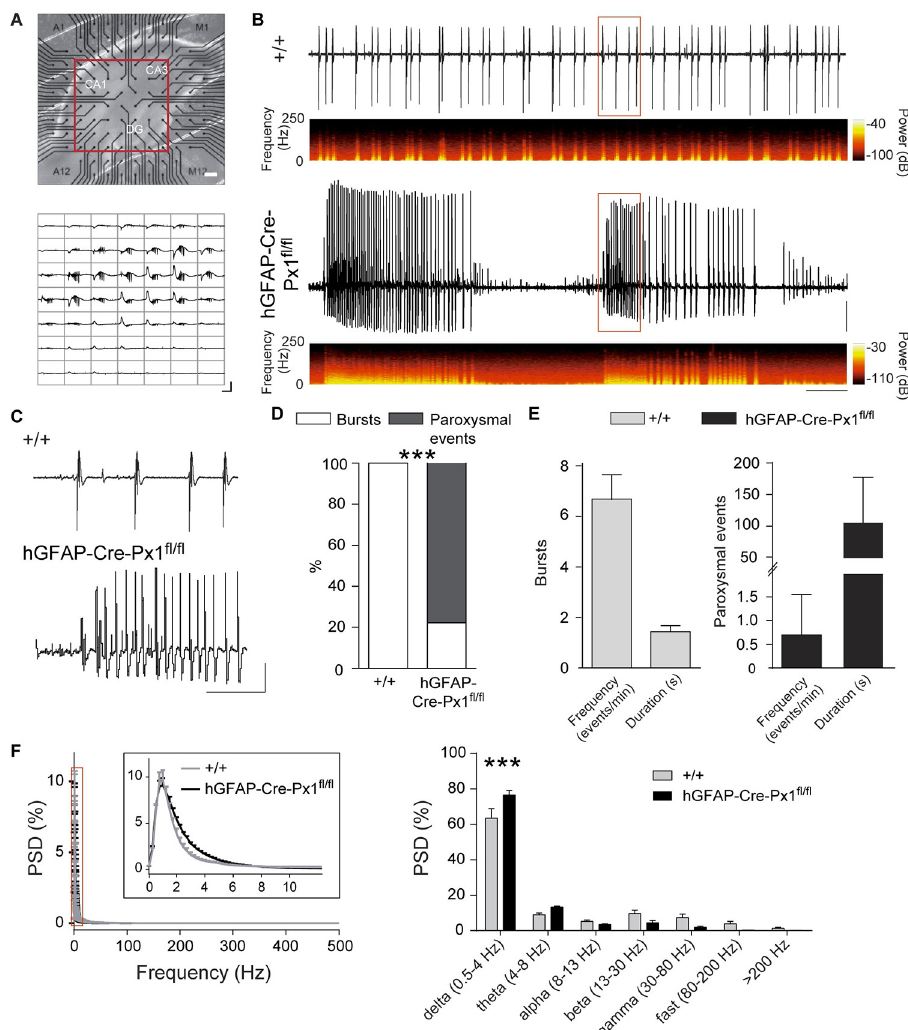
Fig 2. Astroglial Px1 deficiency induces paroxysmal activity. ( A ) Top panel, hippocampal slice on a MEA chamber (DG: dentate gyrus). Bottom panel, illustration of bursting activity recorded using a MEA device (200 μ m interelectrode distance) in hippocampal slices. Scale bar: 500 ms, 0.3 mV. ( B ) Representative traces of bursting activity in +/+ mice (upper trace) and paroxysmal activity in hGFAP-Cre-Px1 fl/fl mice (lower trace). The corresponding time- frequency plots are shown under the traces. Scale bar: 30 sec, 0.2 mV. ( C ) Magnification of bursting activity in +/+ mice and paroxysmal activity in hGFAP-Cre-Px1 fl/fl mice highlighted by the red rectangles in panel B. Scale bar: 10 s, 0.2 mV. ( D ) Proportion of bursts and paroxysmal events recorded in +/+ and hGFAP-Cre-Px1 fl/fl mice (+/+, n = 13 slices from 6 mice; hGFAP-Cre-Px1 fl/fl , n = 18 slices from 8 mice; Fisher exact test). ( E ) Quantification of bursts and paroxysmal events frequency and duration (+/+, n = 13 slices; hGFAP-Cre-Px1 fl/fl , n = 14 slices). ( F ) Left, power spectral density of activity (normalised to the percent of the total PSD) recorded in +/+ (grey) and hGFAP-Cre-Px1 fl/fl (black) slices. The area highlighted by the red rectangle is zoomed in the inset. Right, power spectral density of left panel binned according to different brain rhythms: delta (0.5–4 Hz), theta (4–8 Hz), alpha (8–3 Hz), beta (13–30 Hz), gamma (30–80 Hz), fast (80–200 Hz), and > 200 Hz oscillations (+/+, n = 13 slices; hGFAP-Cre-Px1 fl/fl , n = 12 slices; p = 0.002, repeated measures two-way ANOVA). Asterisks indicate statistical significance ( � p < 0.05; ��� p < 0.0001). The data underlying this figure can be found in the S1 Metadata B tab. hGFAP-CreERT2 treated with TF) mostly displayed bursting activity (86%, n = 12 out of 14 slices from 3 mice for +/+ + TF; 77%, n = 20 out of 26 slices from 4 mice for hGFAP- CreERT2 + TF; p = 0.0106 and 0.027, respectively; S4C–S4G Fig). These results thus indicate that postnatal deletion of Px1 specifically in astrocytes limits neuronal population activity.